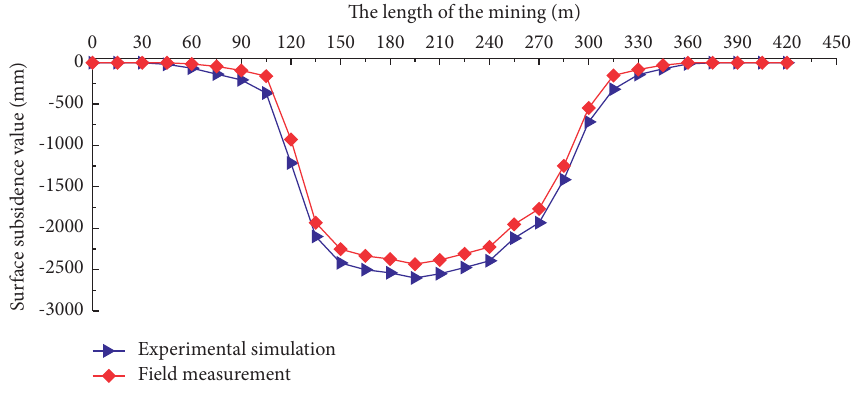
Figure 9: Surface subsidence